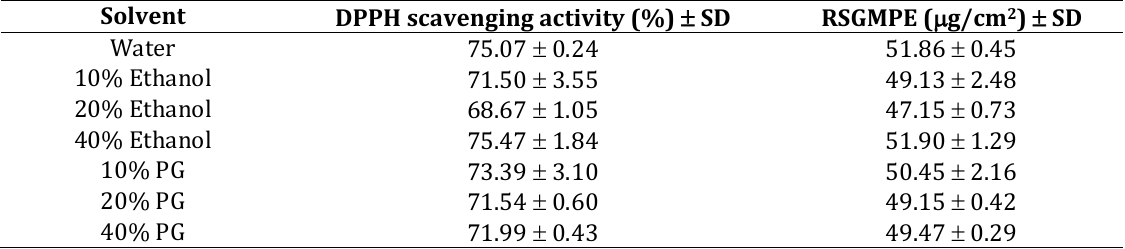
Table II. Percentage of radical DPPH scavenging activity and corresponding RSGMPE concentration estimated to the skin